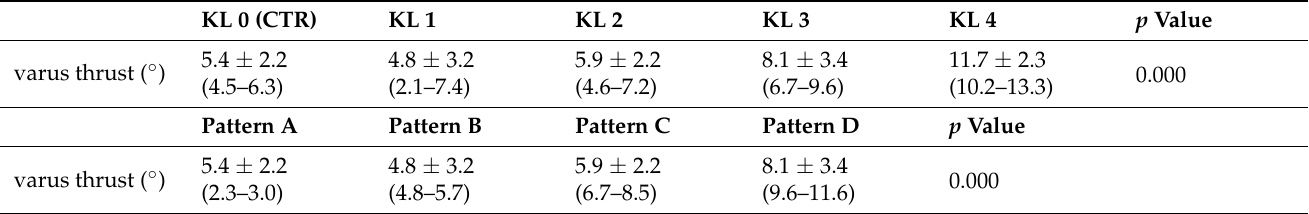
Table 4. Quantitative varus thrust for each KL grade and IMU